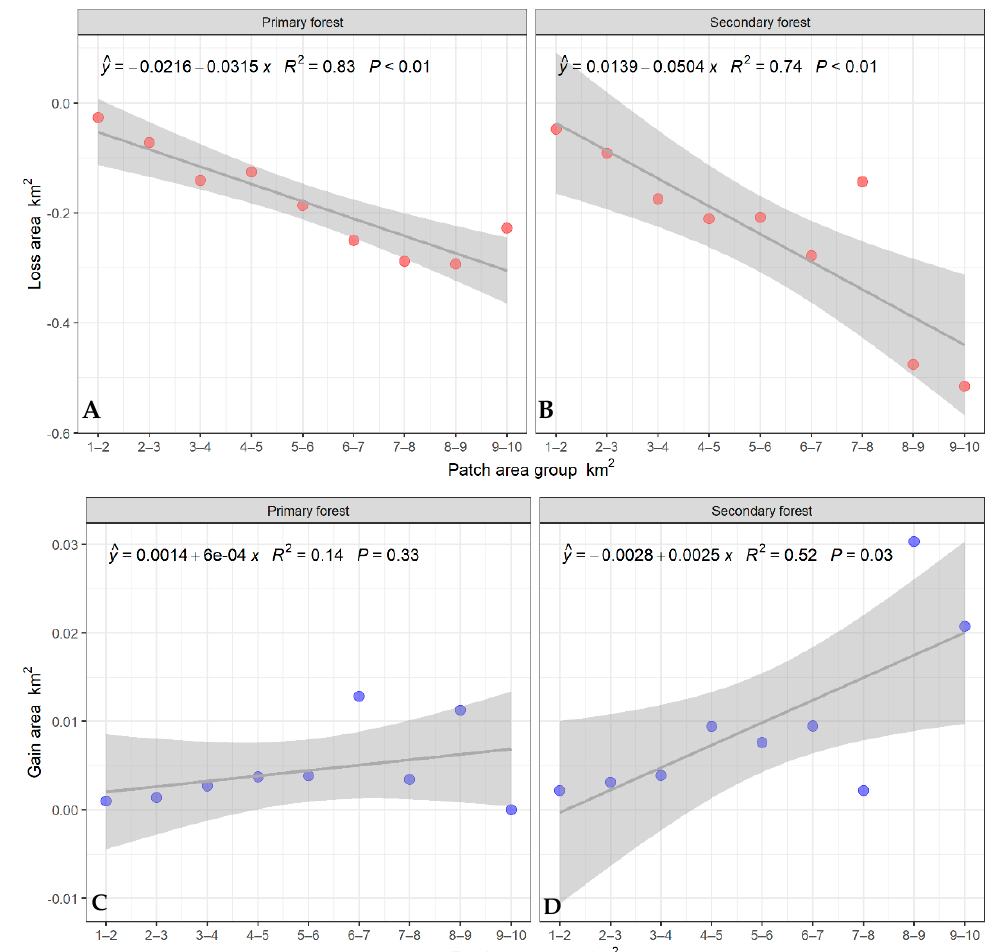
Figure 6. ( A ) Forest loss is more strongly related to patch size in primary forests ( B ) and is similarly related in secondary forests, which experience larger overall losses. ( C ) Similarly, forest gain is weakly related to size class in primary forest ( D ), yet strongly positively related to fragment size in secondary forests.